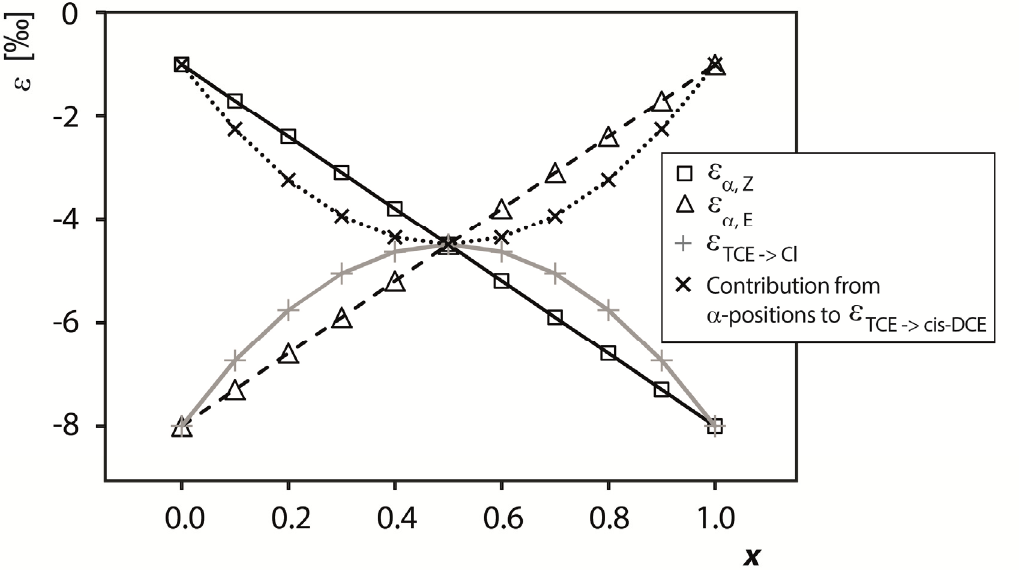
Figure 1. Representation of parameters ε dependence of x , the percentage of Cl − secondary isotope effects were ε Similar scenarios are obtained if the values are allowed to vary between the positions (see